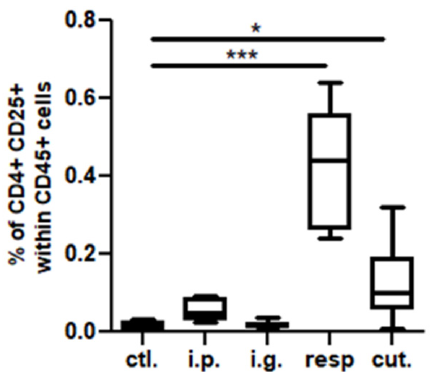
Figure 8. Activated T cells in BAL: CD4 + CD25 + cell concentrations in BAL from mice exposed through the different routes. * p < 0.05; *** p < 0.001: Using non-parametric Kruskal–Wallis test and Dunn’s post-test when comparing all groups to control one (non-exposed mice).